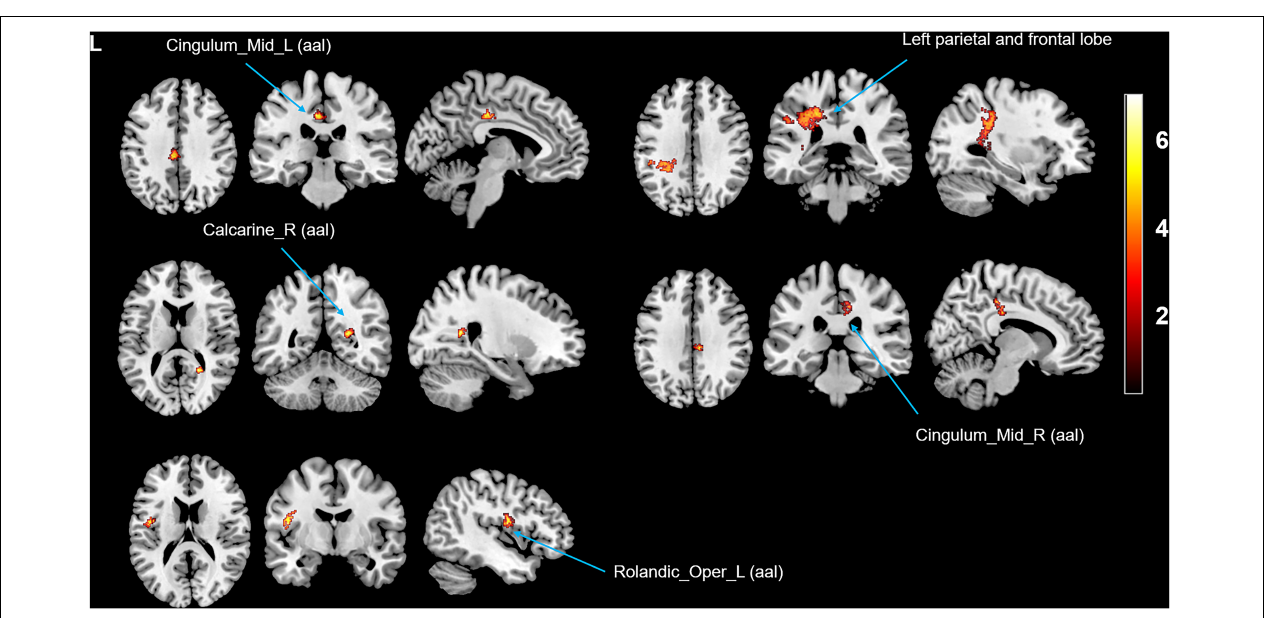
FIGURE 3 | Intergroup differences in WMV between the tinnitus patients before and after sound therapy. Compared with baseline, after sound therapy, the patients with tinnitus exhibited increased WMV in the cingulum (cingulate), right calcarine, left rolandic operculum, and left parietal and frontal lobes (corrected at the non-stationary cluster level with FWE p < 0.05). FWE, family wise error, WMV, white matter volume. The color bar represents the extent of reduction in